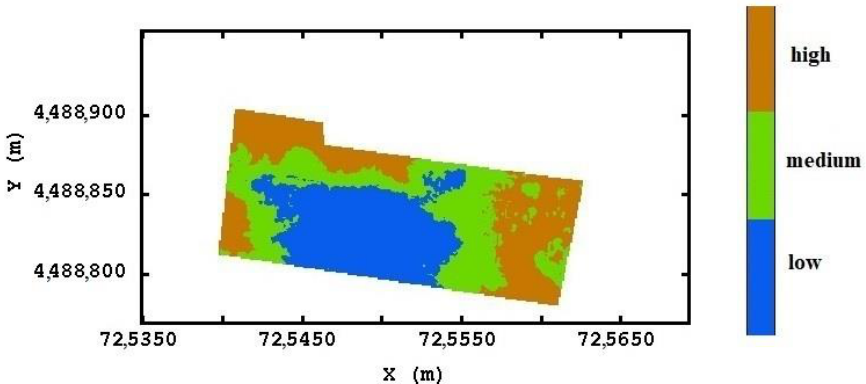
Figure 14. The map of the first long-range factor split into three areas of about equal size on the basis of the content of the finest component of granulometry.